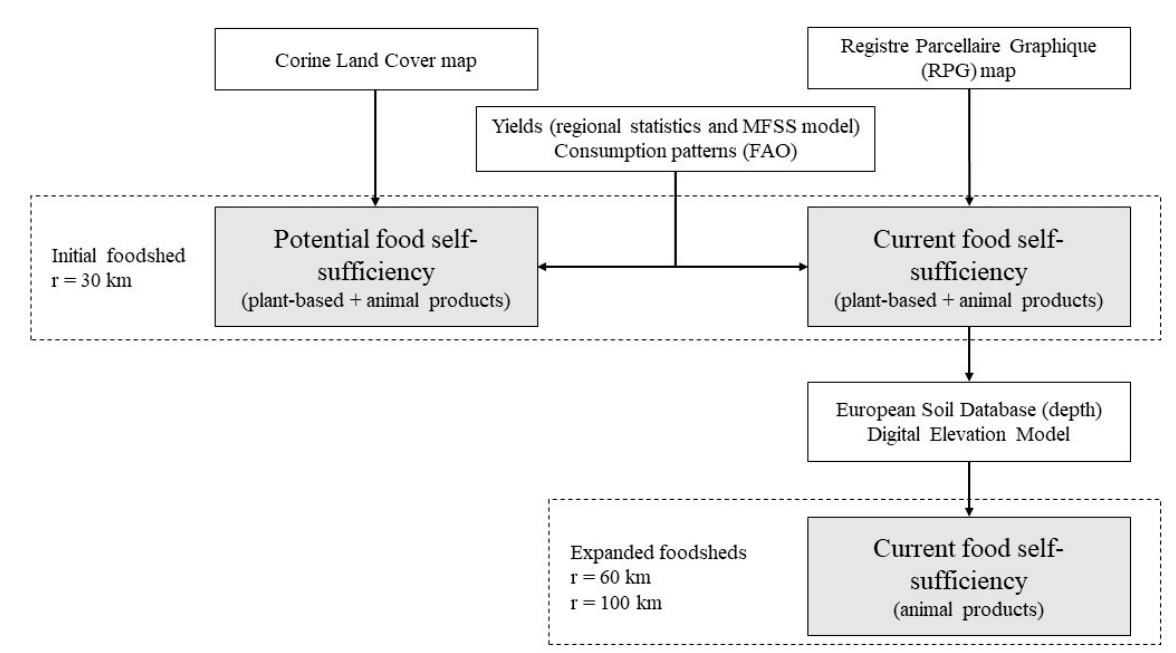
Figure 3. Scheme of the methodology followed in the study.